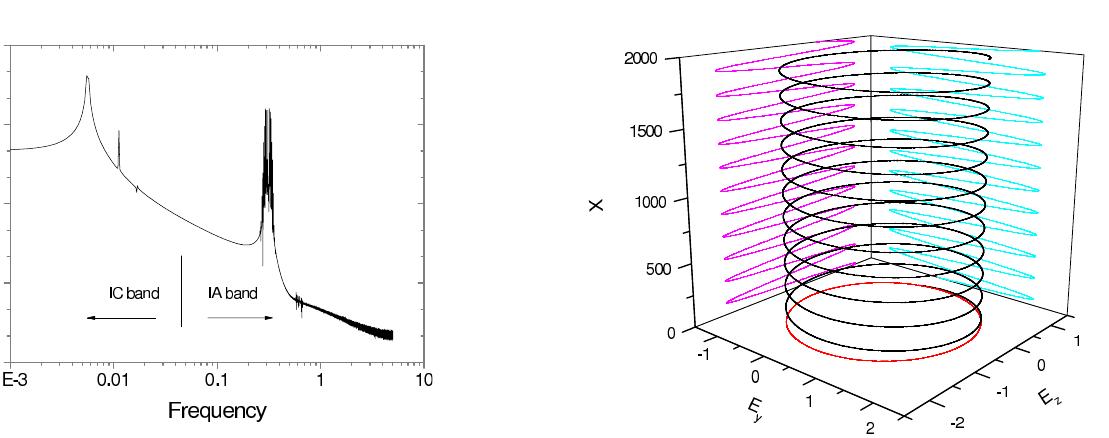
Fig. 6. Non-propagating circular polarization IC wave constituted by E y and E z oscillations accompanying the sinusoidal E x solitary